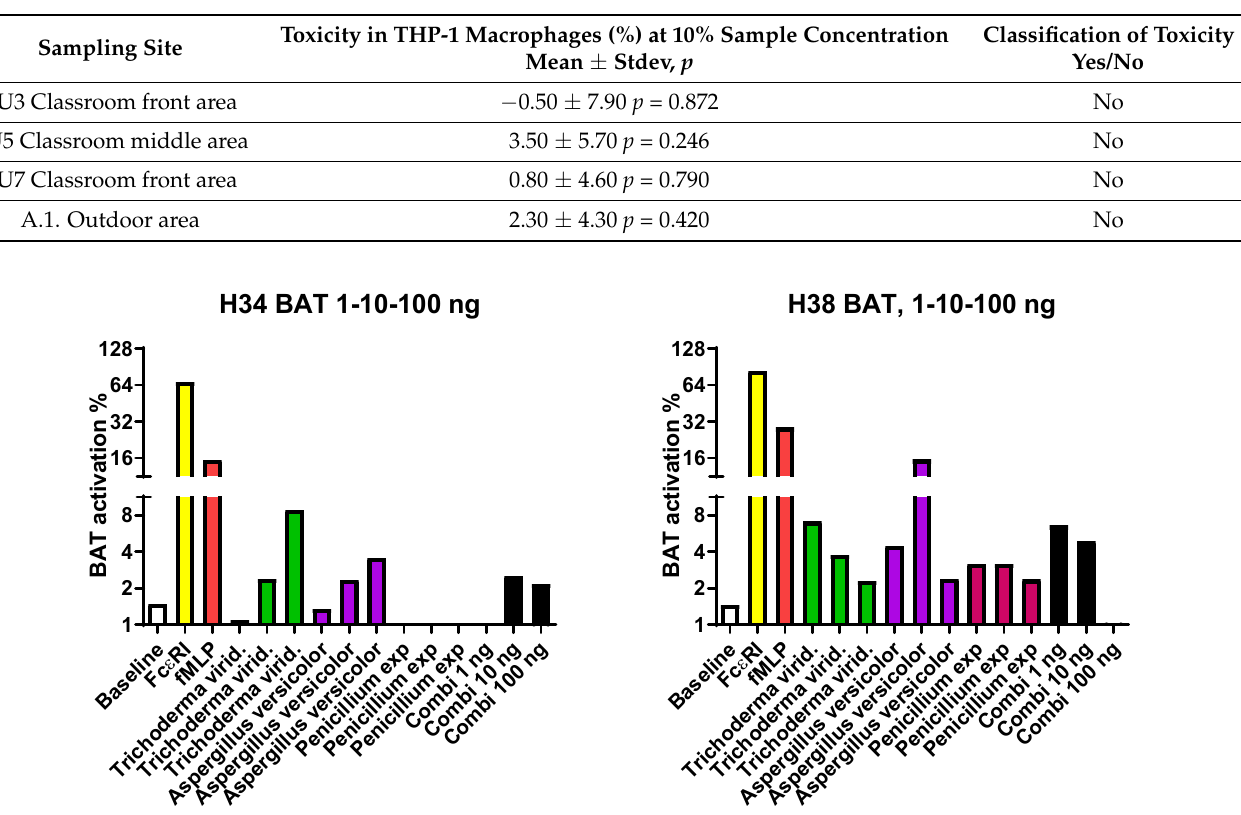
Table 4. The indoor air water samples from the control building did not induce toxicity in THP-1 tests, and sampling was performed by one inspector. Results are provided as mean ± stdev; p < 0.05 means that the result is statistically significant; p > 0.05 means that the result is not statistically significant.